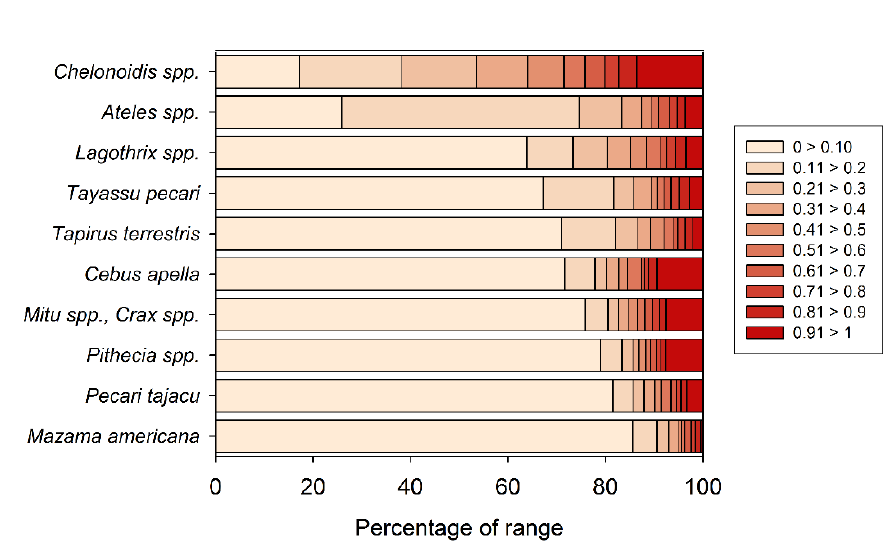
Figure A3. Depletion levels estimated for 10 species of large vertebrate, within their known geographic range distribution within Amazonas state,